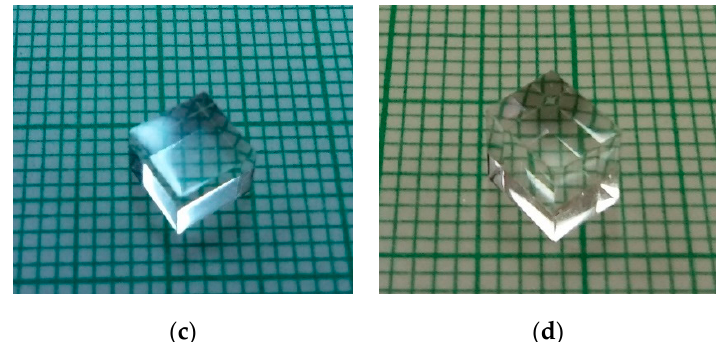
Figure 1. BaWO 4 : Ce single crystals (mm) and cubes (5 × 5 × 5 mm): ( a , c ). 0.5 at. %, ( b , d ). 1 at. % obtained by the Czochralski method.